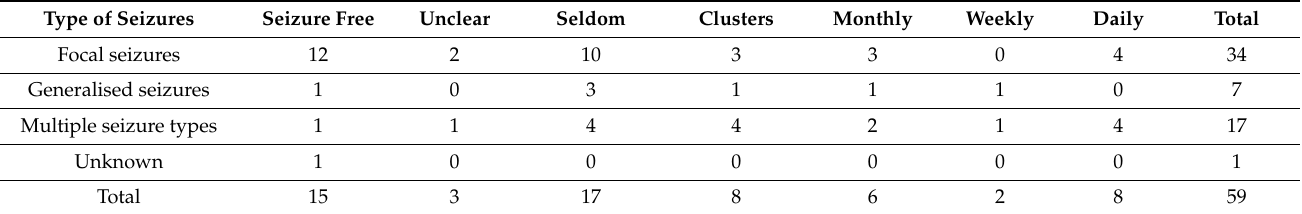
Table 3. Seizure frequency in 59 children with cerebral palsy and epilepsy at the age